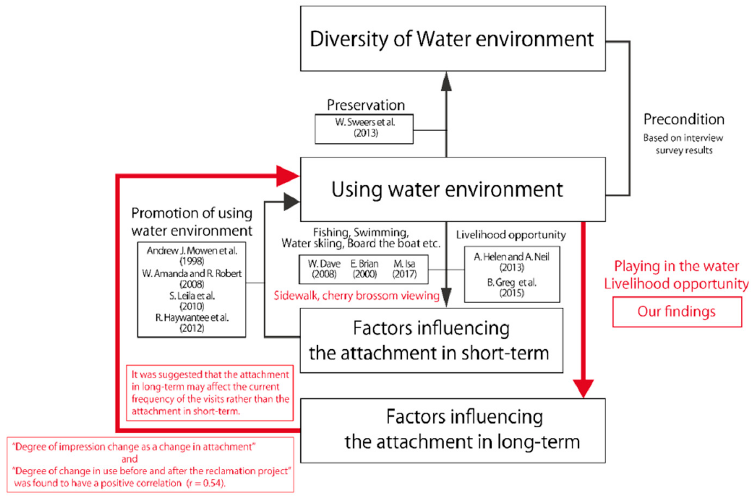
Figure 14. Findings based on the theoretical framework.